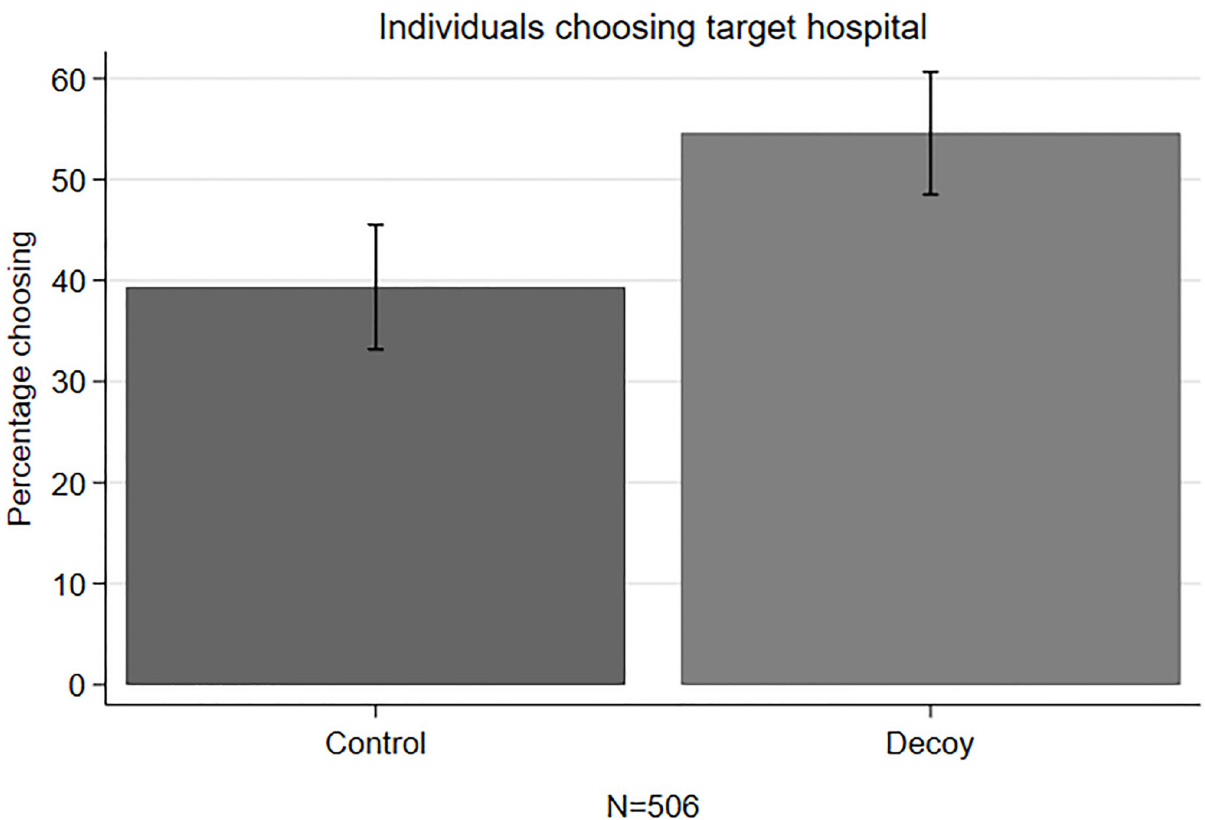
Fig 3. Mean percentage of choosing the target hospital.